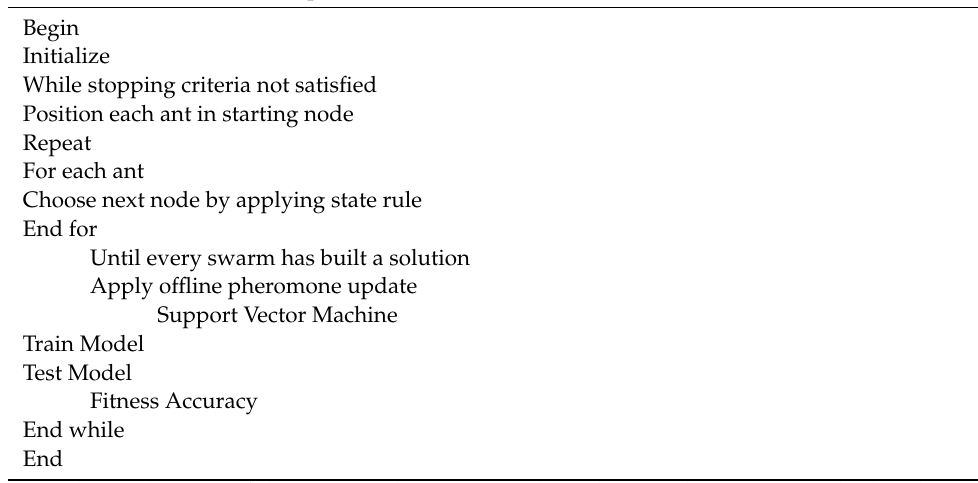
Algorithm 4. The PSO-SVM